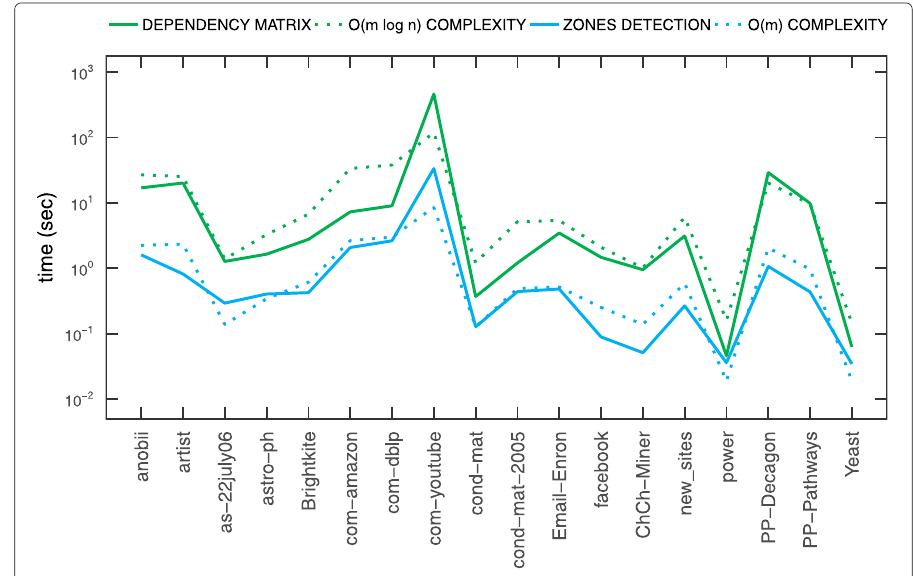
Fig. 17 Estimated time complexity. The dotted lines represent estimated time complexities approximating computation time of the dependency matrix calculation (green) and detection of all zones (blue) in the networks that were